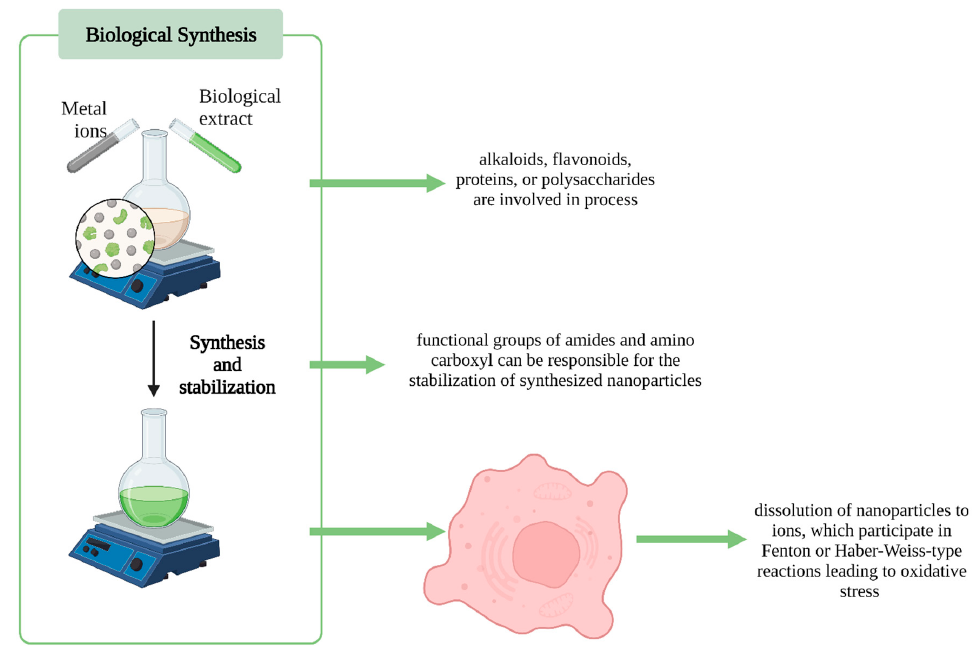
Figure 2. Summary of green nanoparticle synthesis (Created with BioRender.com, accessed on 29 July 2022). Table 1. Summary of analysis of selected biosynthesized